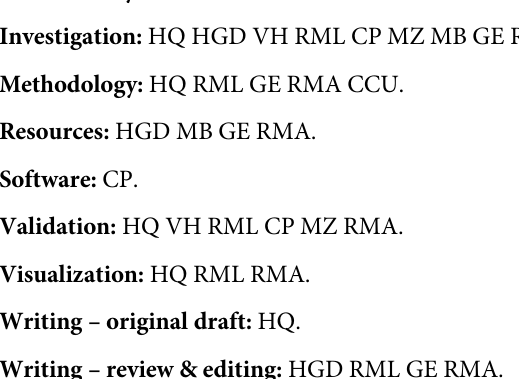
S2 Table. 46 top outliers in U-2946 vs. 55 B-lymphoma cell lines. Outliers are listed accord- ing to chromosomal position. Note the perfect correlation between genomic imbalances and expression in cell line U-2946, 6/6 hemiploid genes (black and bold) being repressed, 5/5 amplified genes (red and bold) being overexpressed. Up, higher than average; down, lower than average. (XLSX) S3 Table. Amplified genes in cell line U-2946. Amplified genes on 1q21.3 are listed from cen- tromere to telomere, genes on 17p11.2 from telomere to centromere. Bold: strongly expressed genes as assessed by expression array analysis.